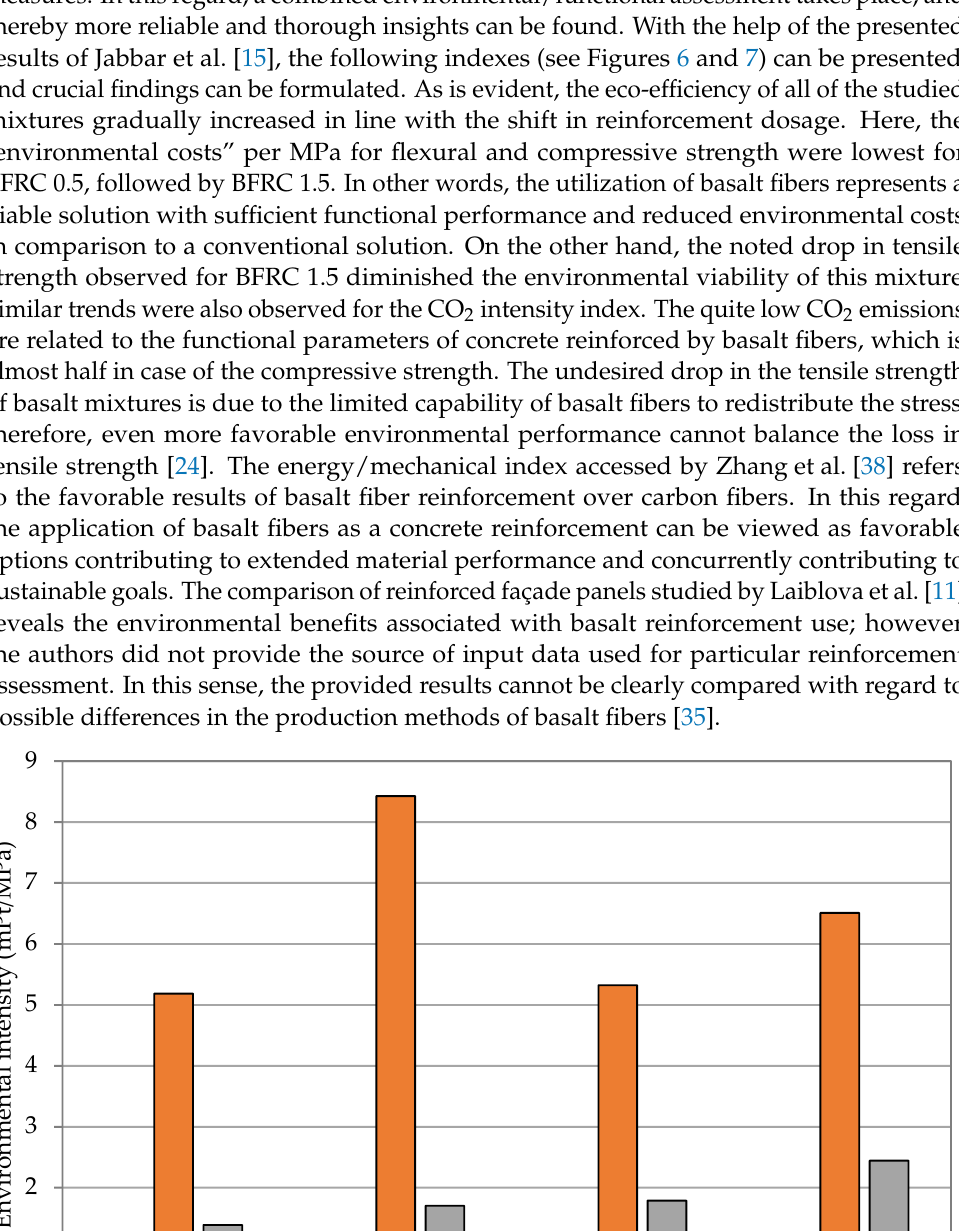
Figure 7. CO 2 intensity comparison of concrete reinforced by basalt and steel fibers. 4. Conclusions Facing the new challenges in materials engineering based on the integration of envi- ronmental consequences of human activities, a detailed description of material alterna- tives needs to be provided. In order to correspond to the lacking data related to basalt fiber production, the performed study provides an environmental analysis of basalt fiber production with the help of LCA. As is evident from the results of the employed analysis,